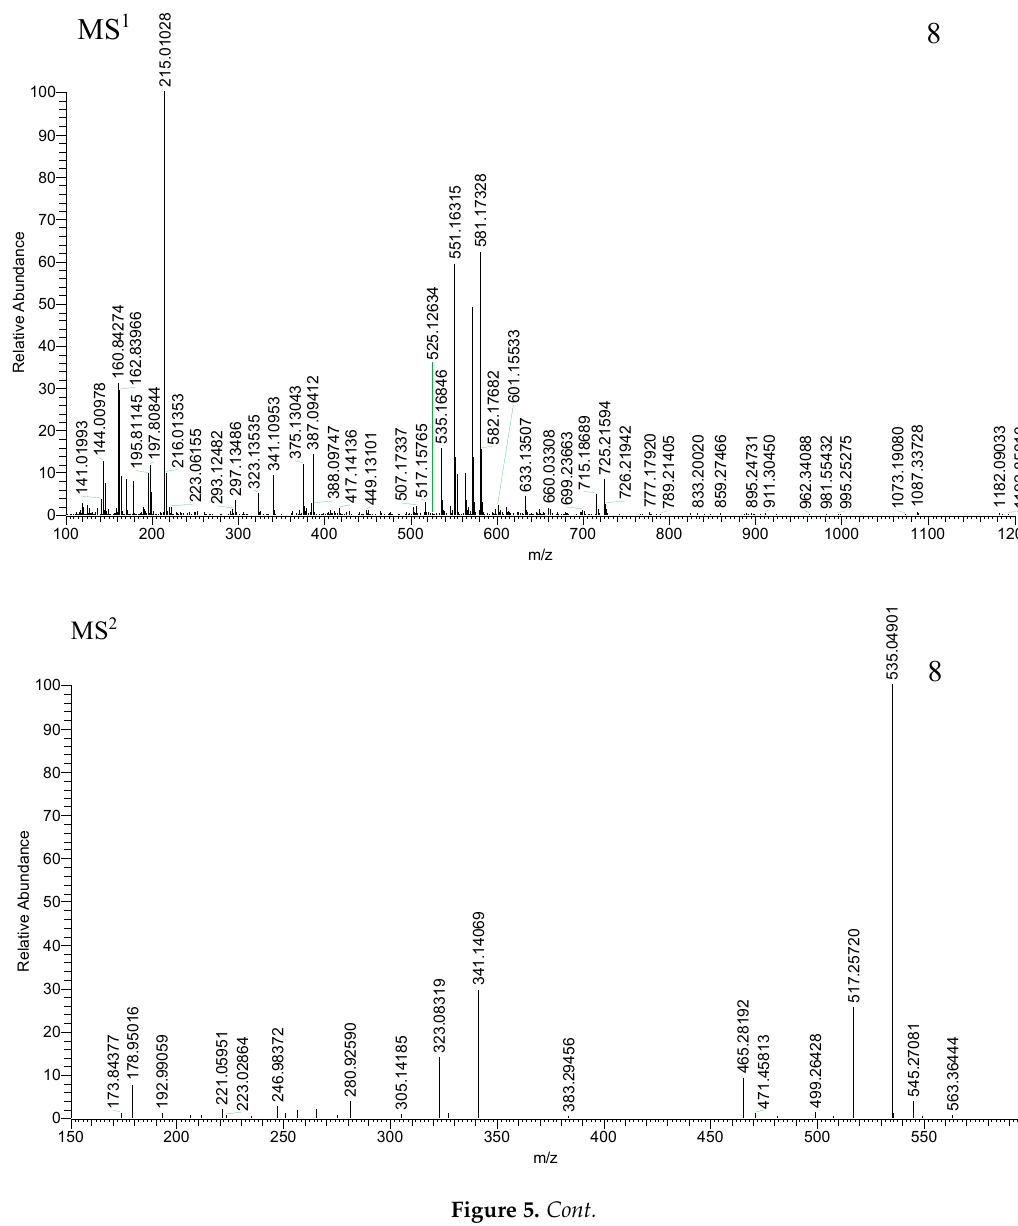
Figure 5. Cont. Figure 5.